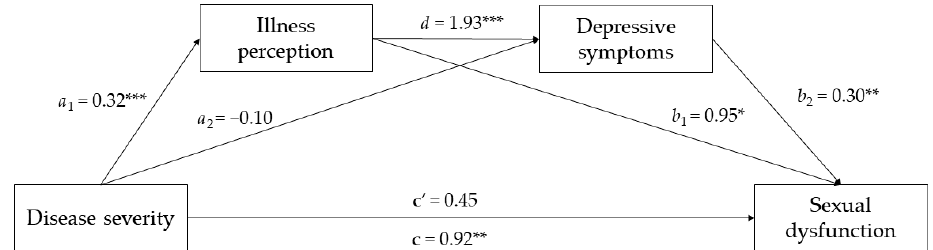
Figure 2. The mediated effects of illness perception and depressive symptoms on the relationship between disease severity and sexual dysfunction. * p < 0.05; ** p < 0.01; *** p < 0.001.